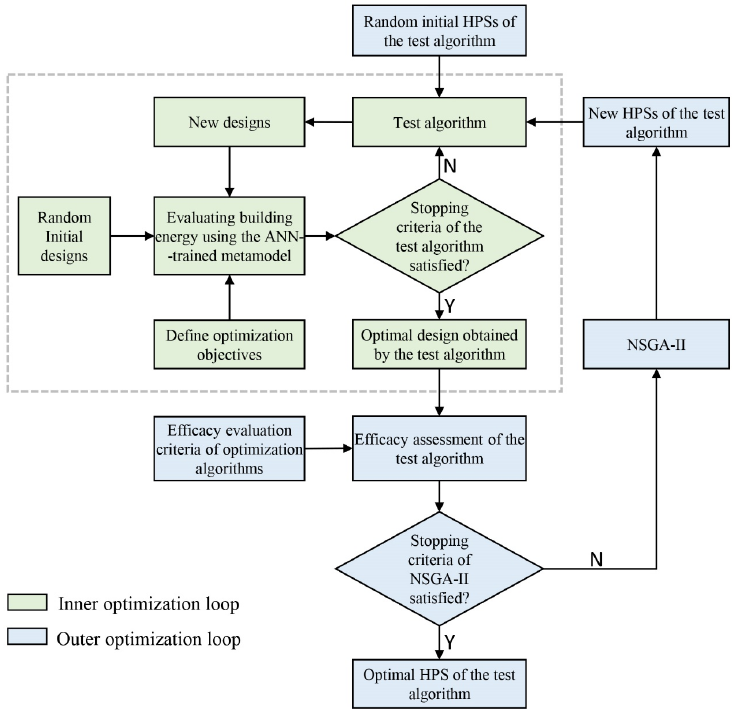
Figure 4. Flowchart of hyperparameter optimization of the test algorithm applied in BEO.